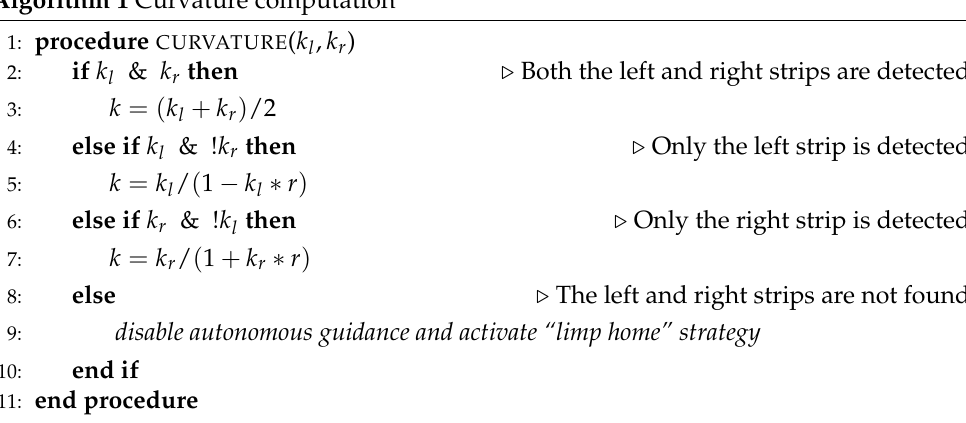
Algorithm 1 Curvature computation